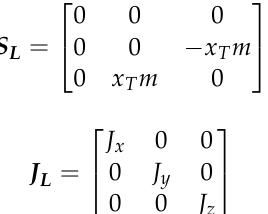
wherein E is kinetic energy, U is potential energy, D is dissipative energy, 𝐹⃗ is general- ised force and moment, 𝑞⃗ is generalised position, and 𝑞(cid:4662)⃗ is generalised velocity. As gen- velocity 𝑢(cid:4662)(cid:4652)⃗ (cid:3013) and vector of angular position 𝜑(cid:4652)⃗ resp. velocity 𝜑(cid:4662)(cid:4652)⃗ . wherein S L represents the antisymmetric tensor (5) related to the vector of the first moment of inertia respecting the origin L of the local coordinate system and J (6) respecting the origin L of the local coordinate system. vector of velocity 𝑢(cid:4662)(cid:4652)⃗ (cid:3013) (3) and the vector of angular velocity 𝜑(cid:4662)(cid:4652)⃗ (4) becomes: